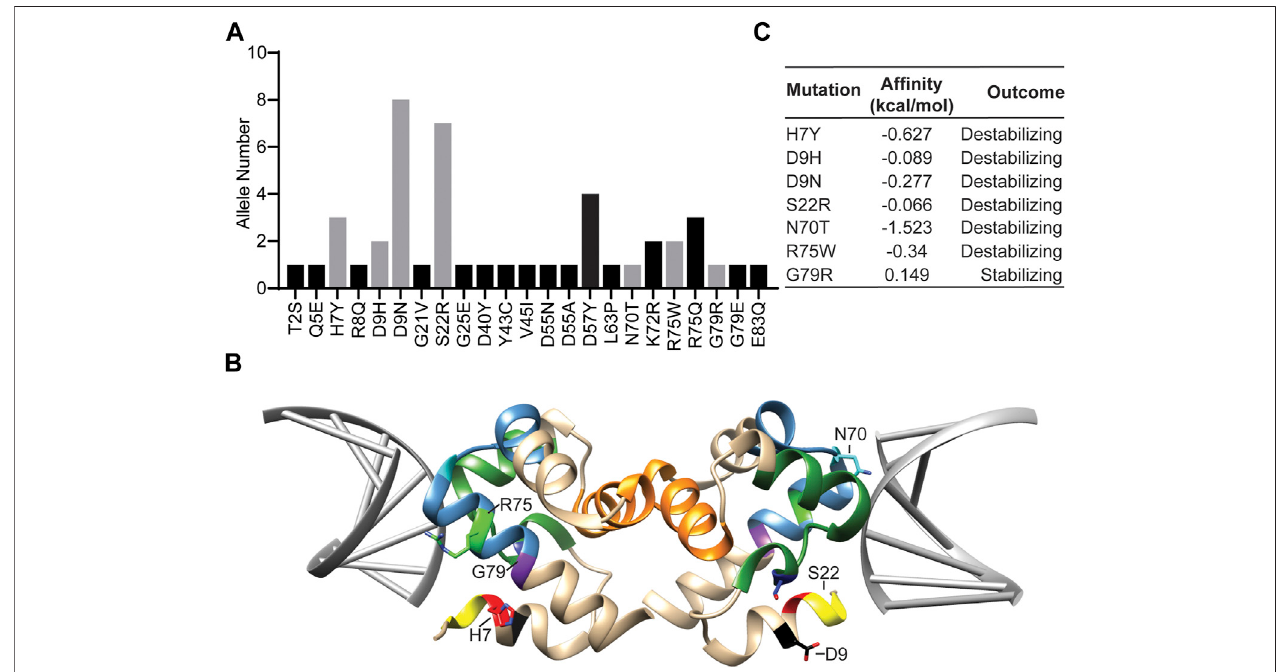
FIGURE1| RarehumanBanf1variantsidenti fi edfromthegnomADservershowalteredpredictedDNAbinding. (A) TheBanf1variantsthatwereidenti fi edfromthe GnomAD server, with the allele numbers shown. The grey bars represent the variants selected for this study. (B) Ribbon representation of the molecular structure of Banf1 dimer (coloured in tan) in complex with DNA double helix coloured in grey (PDB id: 2BZF). H7 is highlighted in red, D9 in black, S22 in yellow, N70 in blue, R75 in green and G79 in purple. Sidechains of some of the highlighted residues are only displayed in one of the Banf1 monomers. (C) Predicted alterations in Banf1 DNA binding af fi nity ( ΔΔ G (kcal/mol) generated by the mCSM server. Negative ΔΔ G (kcal/mol) are de fi ned as destabilising and positive ΔΔ G (kcal/mol) are de fi ned as stabilising the Banf1:DNA interaction.